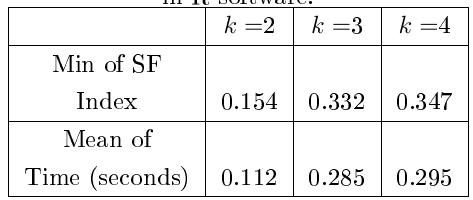
Table 2. The result for three cases of k uses non - hierarchical algorithm for sixteen